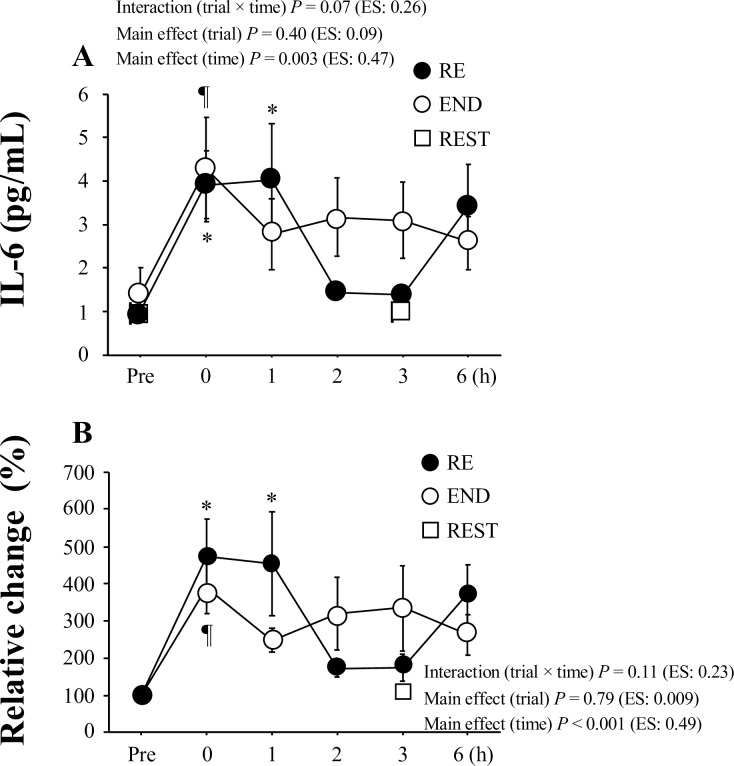
Plasma IL-6 levels before exercise and during the post-exercise period.Absolute levels (A) and relative values compared with the pre-exercise time point (B) are presented. Values present means ± SE. *P < 0.05 vs. Pre (RE). ¶ P < 0.05 vs. Pre (END).